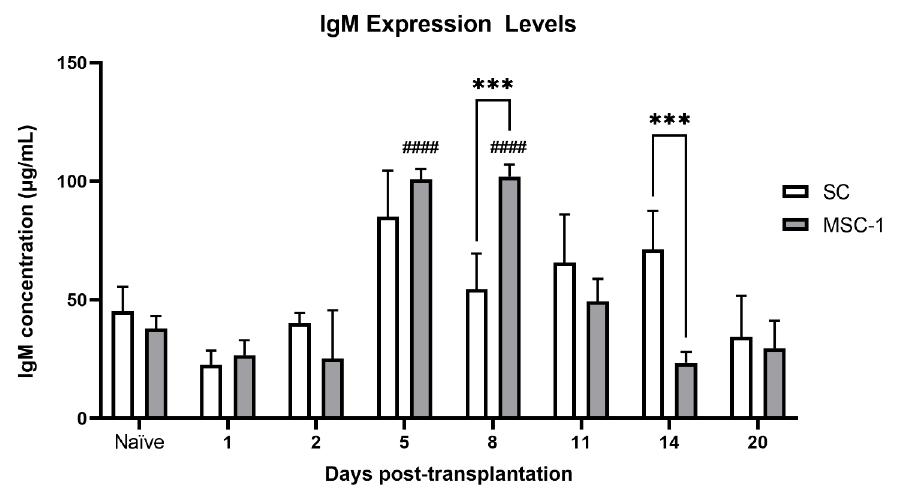
Figure 4. Production of IgM antibodies to grafted SCs or MSC-1 cells. Serum from BALB/c mice transplanted with SCs or MSC-1 cells was collected at days 1, 2, 5, 8, 11, 14, and 20 post transplantation. Serum was also collected from naïve BALB/c mice (mice that did not receive transplanted cells). The production of IgM (μg/mL) against SC (white bar) or MSC-1 (gray bar) grafts was graphed. Data shown are the mean ± SEM for at least three different experiments per timepoint. *** denotes a significant difference of the means as determined by multiple t-tests at p ≤ 0.001 as comparing SC and MSC-1 levels against each other; #### denotes a significant difference of the means determined by one-way ANOVA at p ≤ 0.0001 as compared to respective naïve, pre-transplantation values.